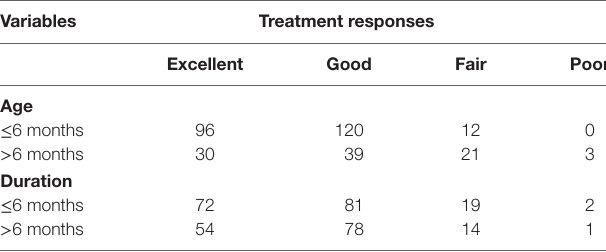
TaBle 3 | Clinical therapeutic differences in age at treatment initiation and duration of treatment. Variables